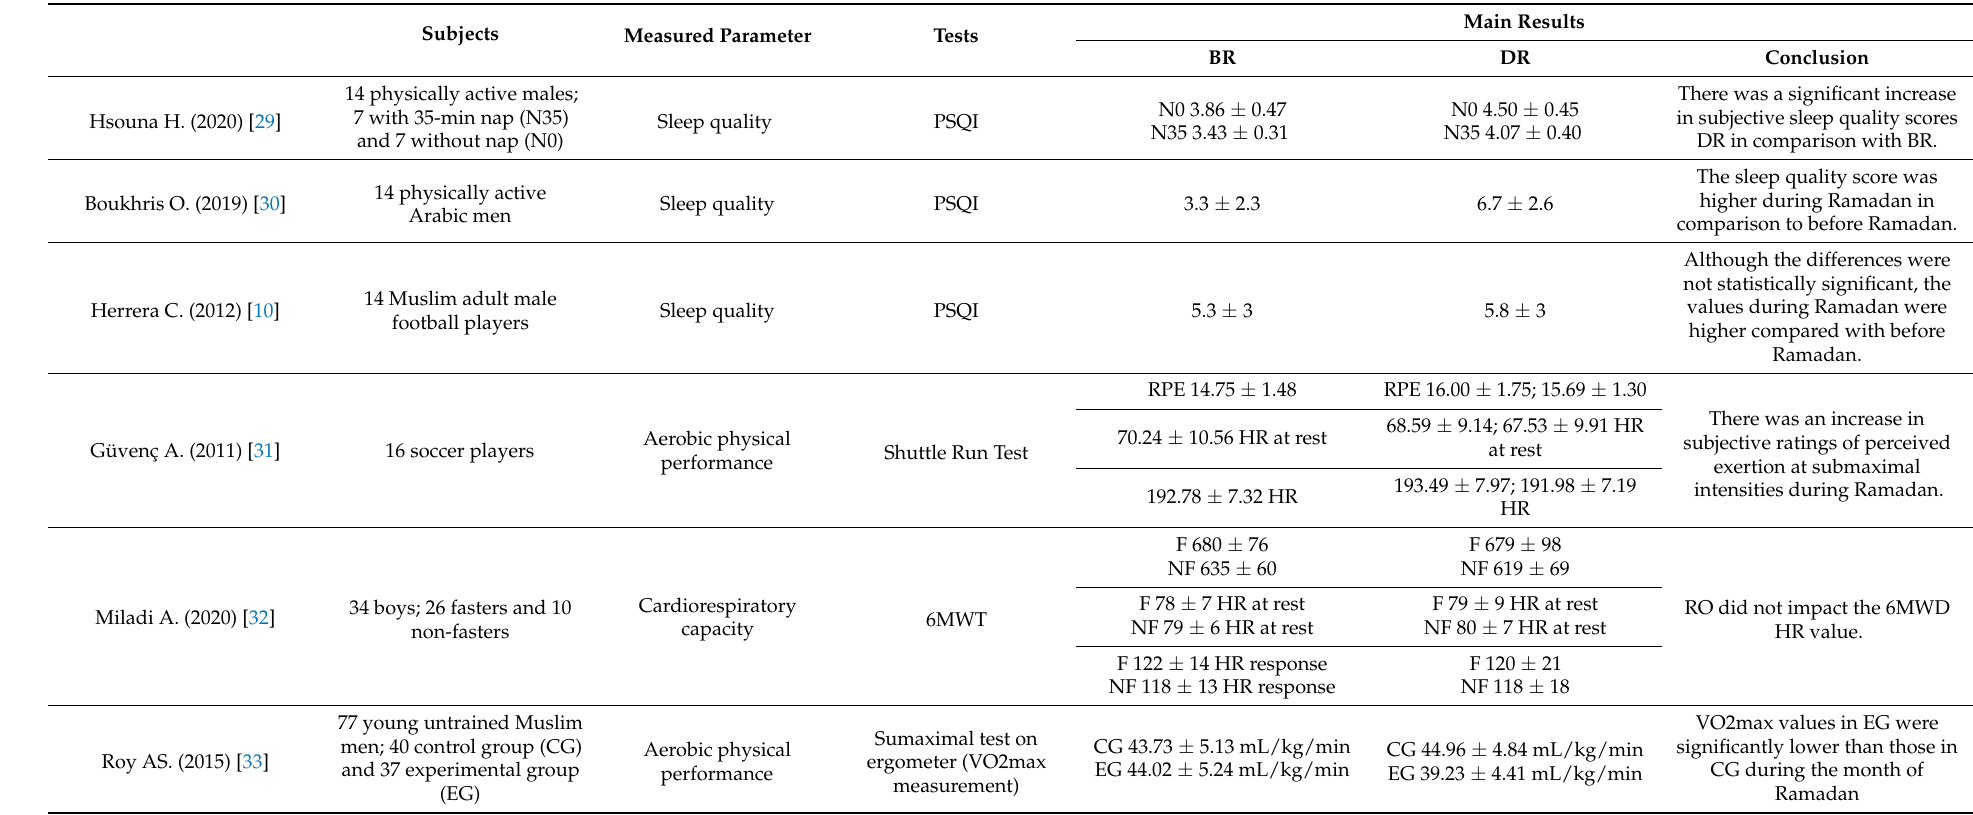
Table 3. Results of previous studies concerning the influence of Ramadan fasting on physical performance and quality of